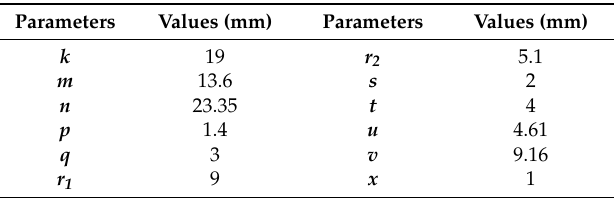
Table 3. Design parameters of the proposed